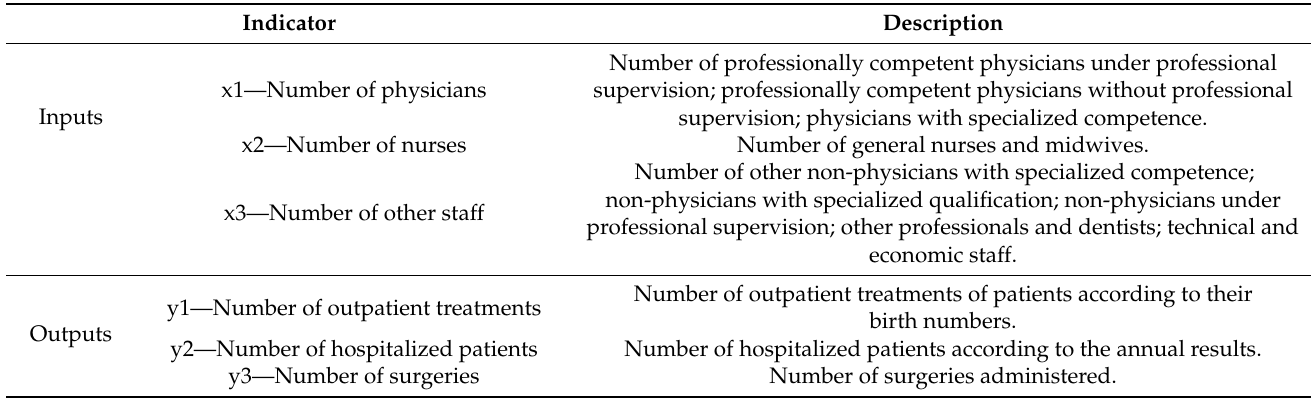
Table 1. Input and output indicators.